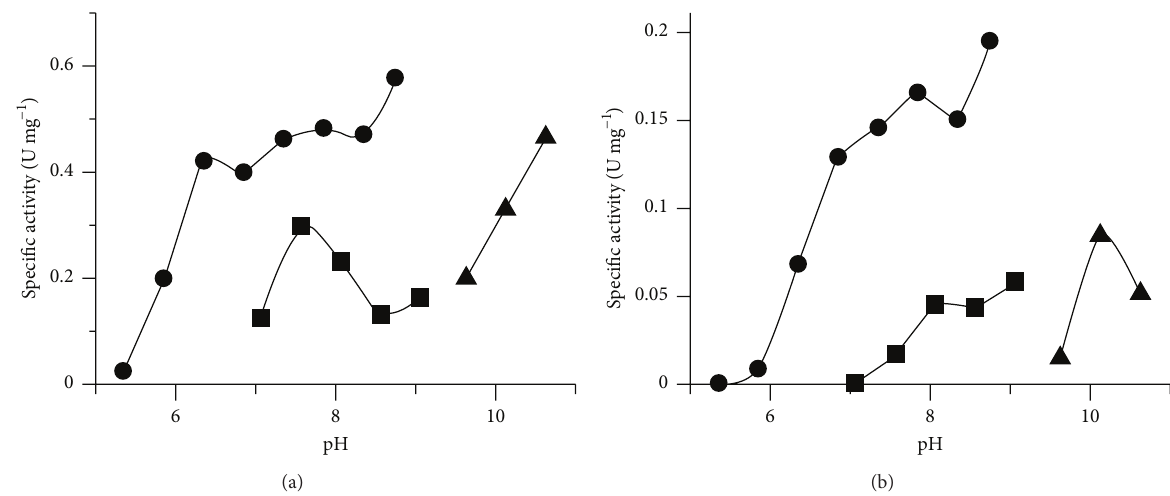
Figure 5: Effect of pH on activity of (a) PeiW and (b) PeiP in synthetic peptide assays. The assays were performed using standard conditions described in Section 2, buffers; e Bistris propane, ◼ Ampso, and 󳵳 Caps.